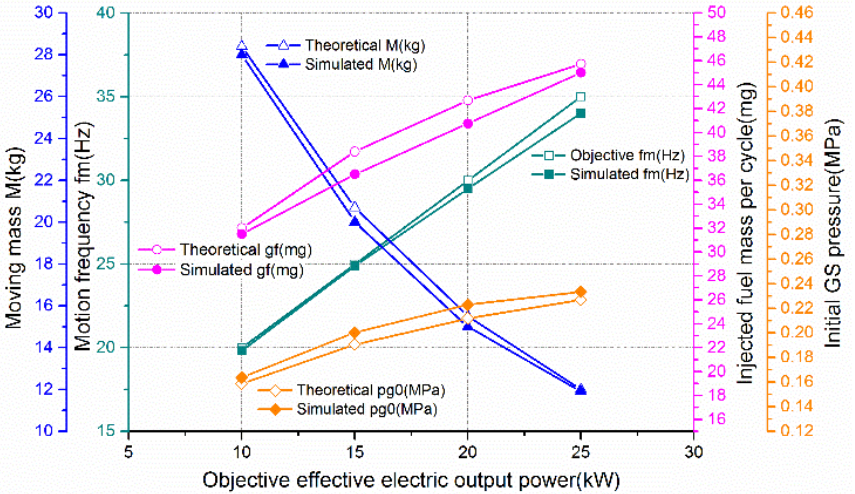
Figure 17. Comparisons of the theoretical and simulated operational parameters for various power demands.